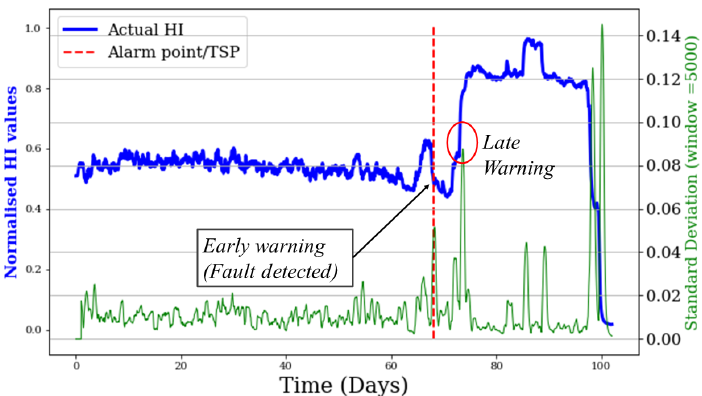
Figure 9. HI illustrating the TSP from the 5 σ technique.